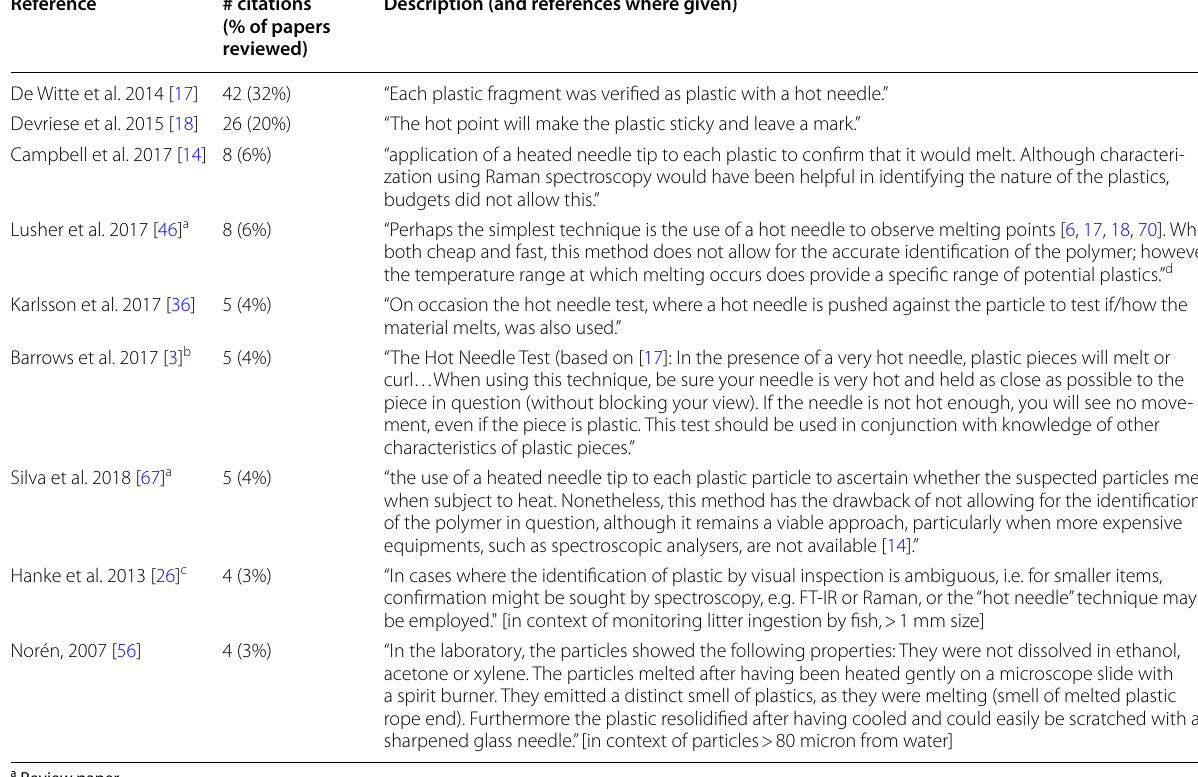
Table 2 Publications most cited for the hot needle test method in the present systematic